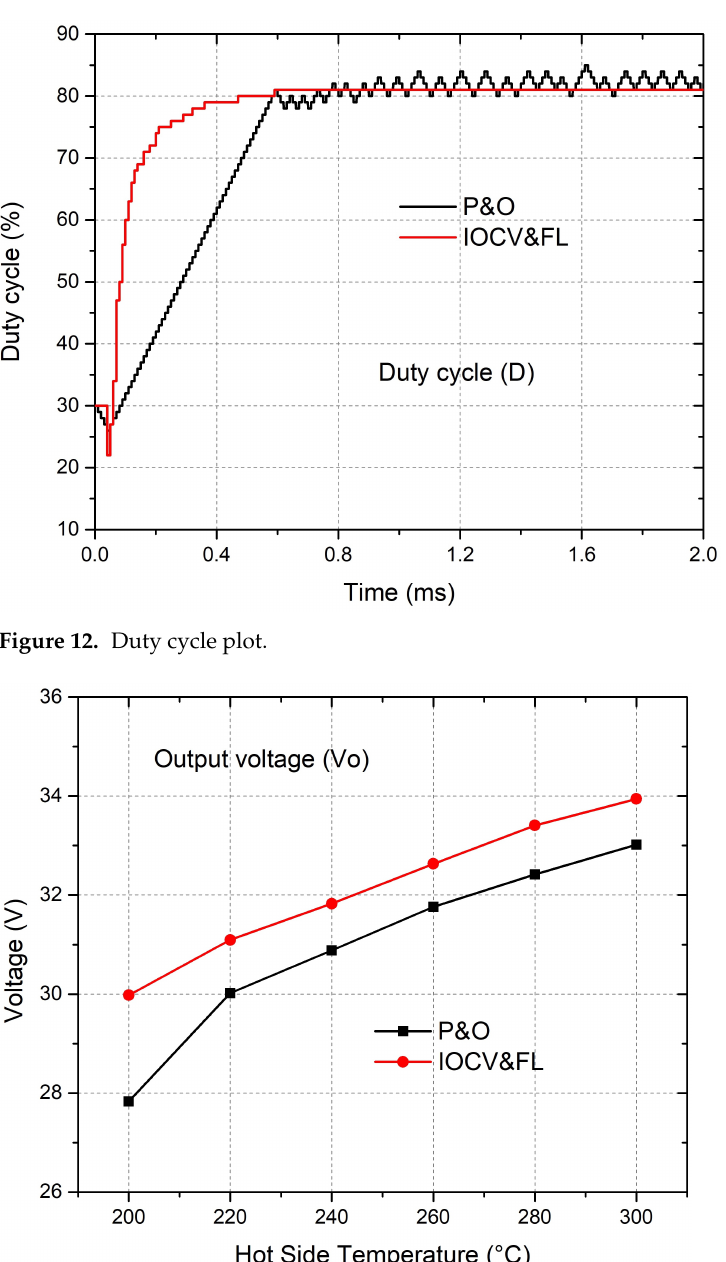
Figure 13. Output voltage plot at different hot-side temperatures. The power obtained by the proposed algorithm has a range of 3.9% to 5.6% larger